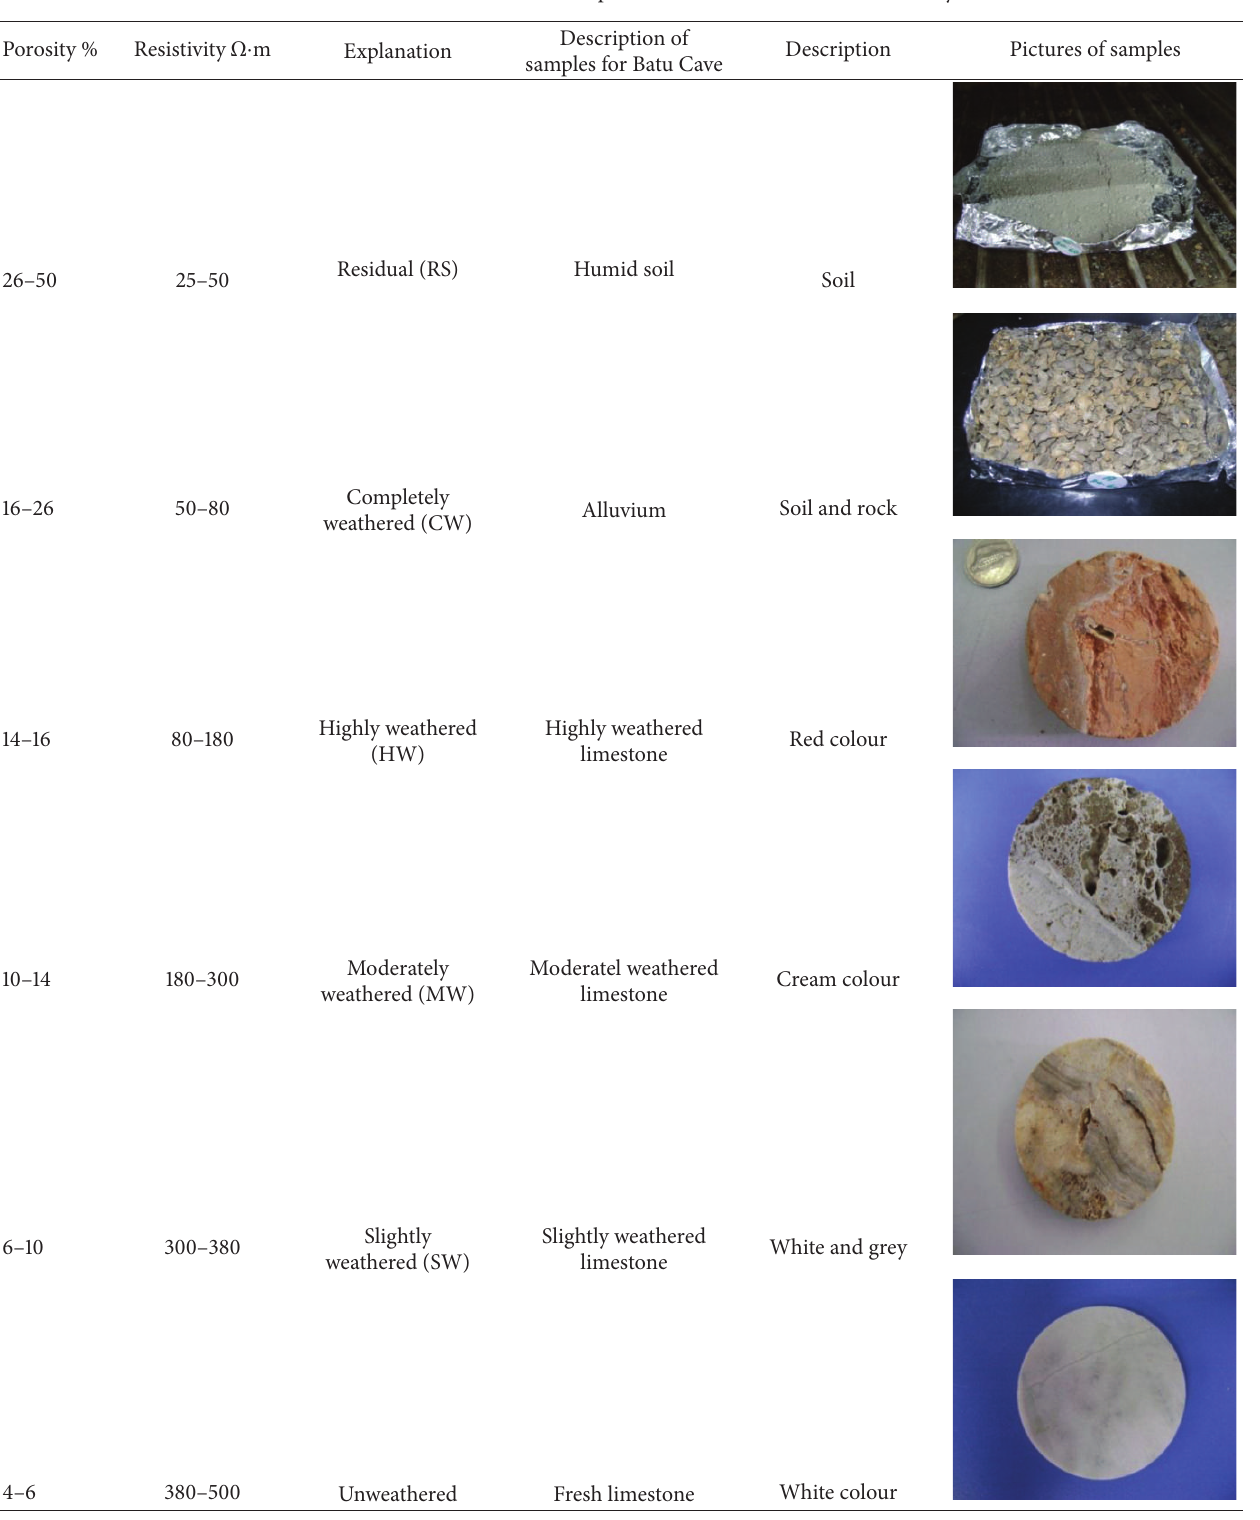
Table 3: Classification use for the description of rock mass/material in the study